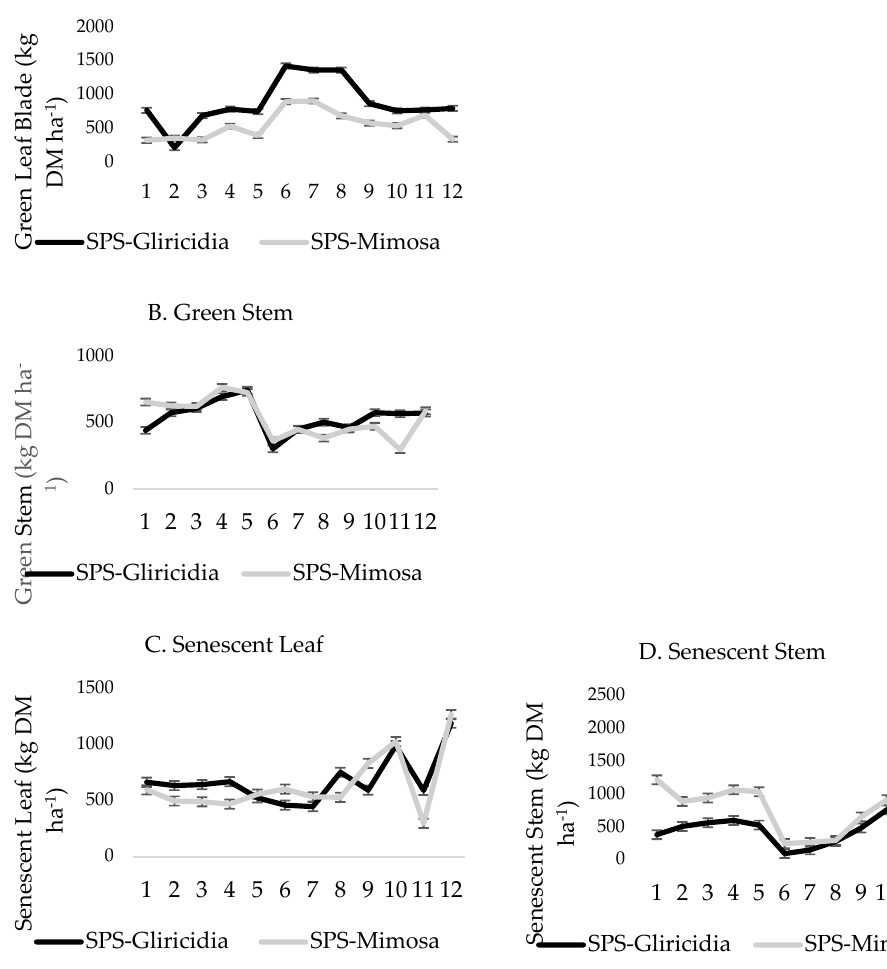
Figure 3. Green leaf blade ( A ), green stem ( B ), senescent leaf blade ( C ) and senescent stem ( D ) during the experimental period. SPS = silvopasture system.